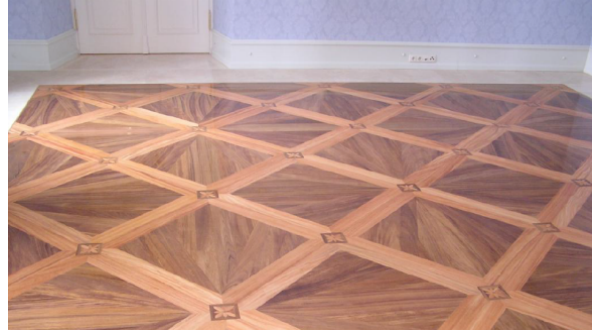
Figure 4: The final effect of surface of the wooden palace floor